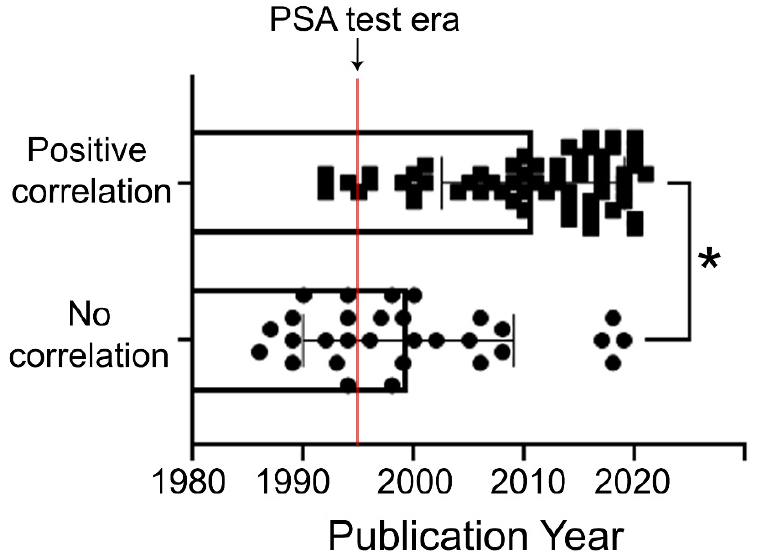
Figure 3. Distribution of epidemiological observations published before and after the implementation of PSA testing in 1995. We found 12 manuscripts published between 1980 and 1995 that deny any link or report a weak association between alcohol consumption habit and risk of PCa. Within these years, only five publications reported the positive connection. In the observations published from 1995 to the present, the ratio of publications showing no link:positive link was shifted to 18:65. There is a significant difference between the publication years of articles with positive correlation and those with no correlation (Mann–Whitney test, * p < 0.0001; median ± SD, the median for no correlation is 1998, median for positive correlation is 2014).